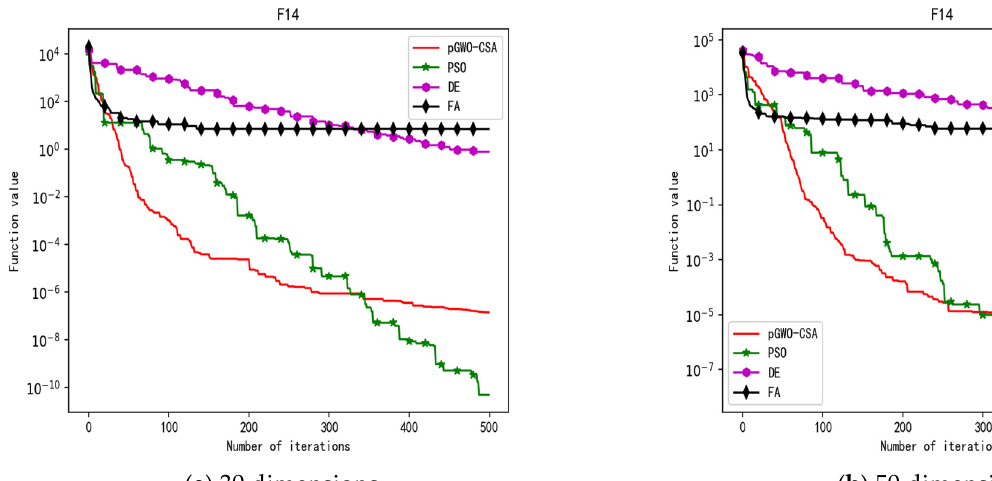
Figure 18. Convergence curve of test function F14.